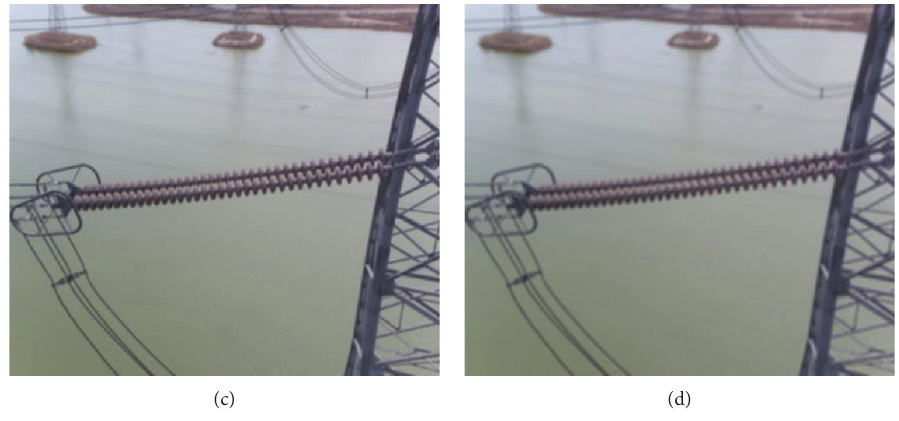
Figure 3: Images burred by different Gaussian blur kernels.